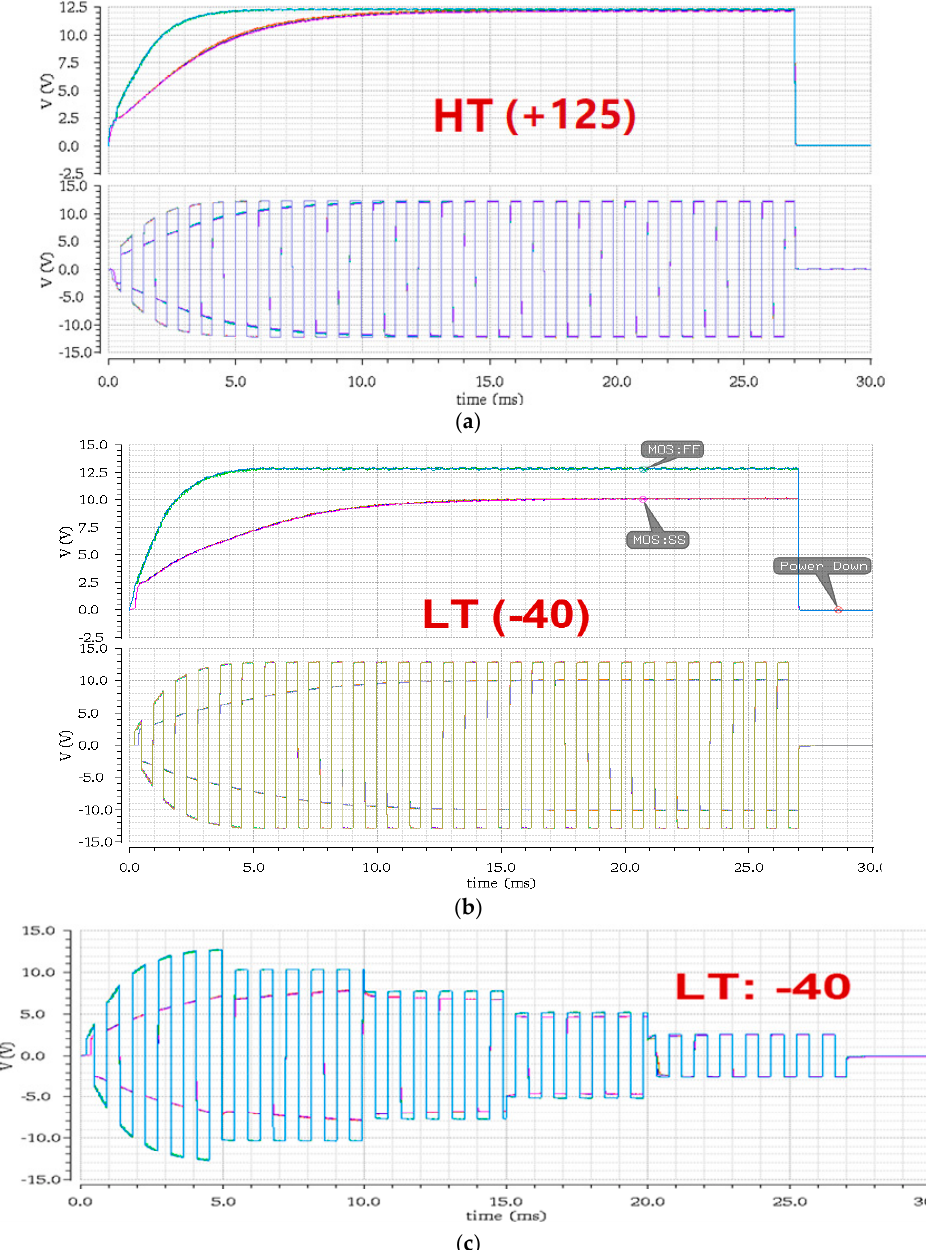
Figure 2. ( a ) The simulation results of the LC driver output (bottom curves) and the charge pump outputs (The top curve in blue in the FF corner and the top one in purple in the SS corner) at high temperature (125 °C); ( b ) The simulation results of the LC driver output (bottom curves) and the charge pump outputs (The top curve in blue in the FF corner and the top one in purple in the SS corner) at low temperature ( − 40 °C); ( c ) The driver output voltage generated in response to staircase control voltage (above) at low temperature ( − 40 °C).